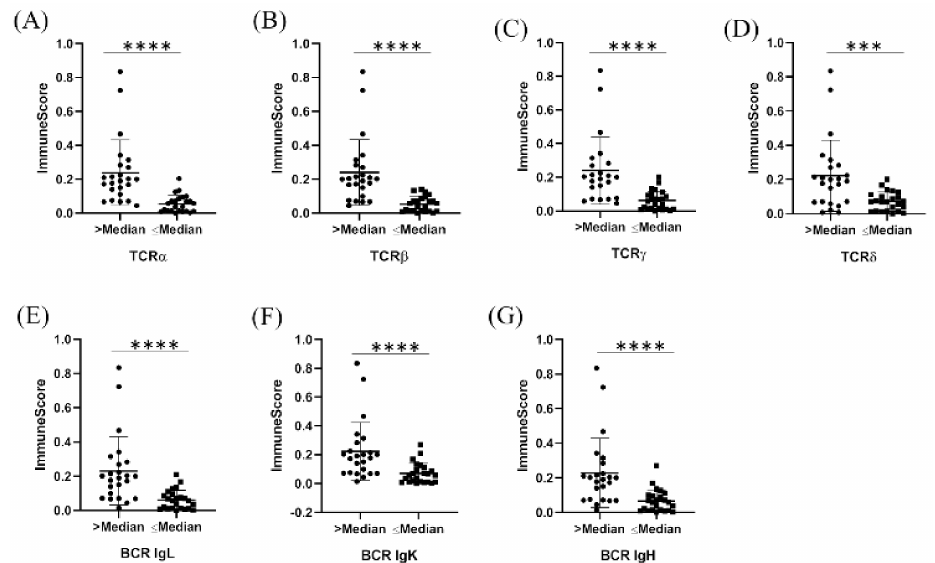
Figure 5. Correlation between clone number of immune receptor repertoires and the Immunoscore, calculated with xCell. ( A ) TCR α , ( B ) TCR β , ( C ) TCR γ , ( D )TCR δ , ( E ) BCR IgL, ( F ) BCR IgK, ( G ) BCR